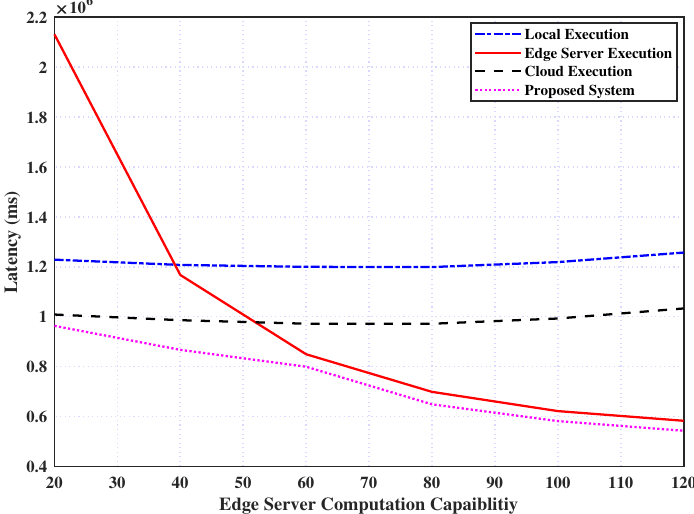
Figure 5. Latency comparison under different values of edge server